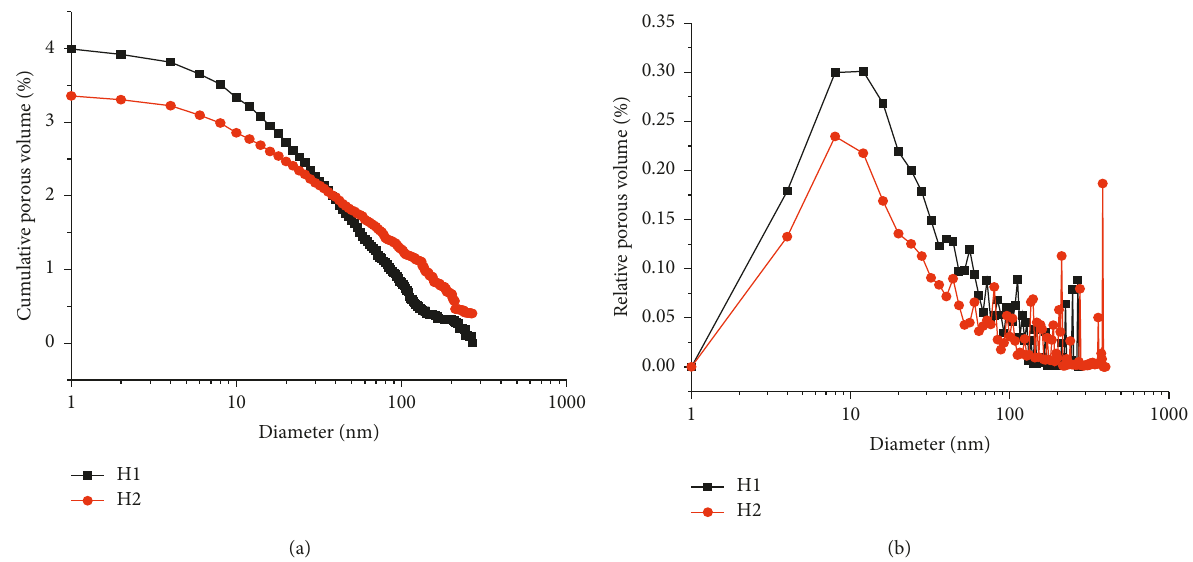
Figure 12: Pore size distribution of hardened cement paste by HIM: (a) cumulative curve; (b) relative curve.